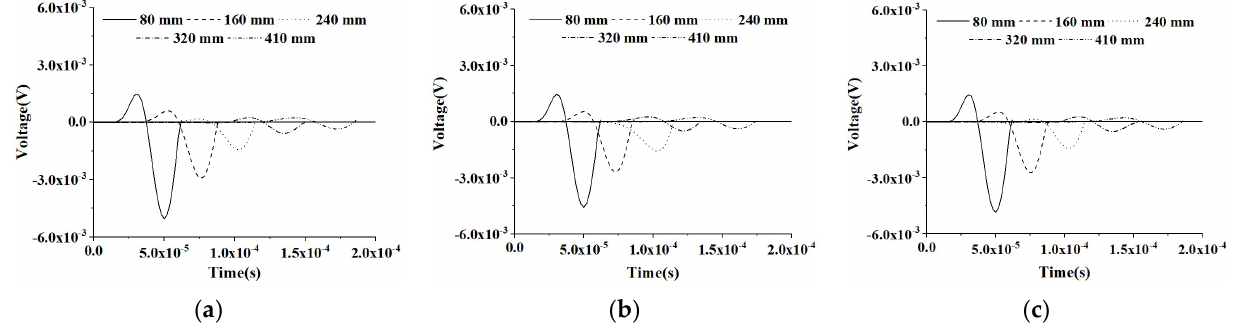
Figure 7. Time-domain response of sensors at different measurement distances from the actuator under a modulated sinusoidal excitation signal for CMFEMs with an interface debond defect. ( a ) CMFEM 1D; ( b ) CMFEM 2D; ( c ) CMFEM 3D.